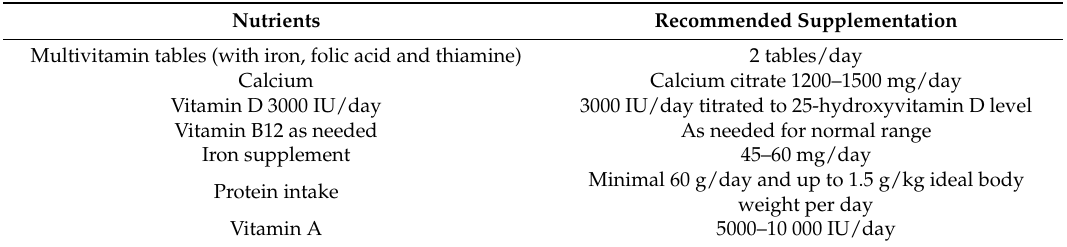
Table 2. Recommended nutritional supplementation after bariatric surgery.